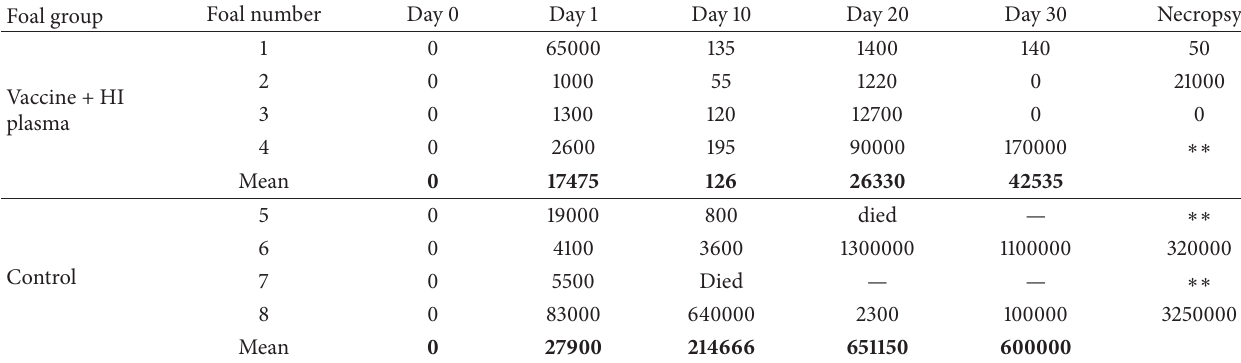
Table 4: Reisolation rate of R. equi from BALF samples (CFU/mL) and lung samples (CFU/gr) after necropsy in foals.